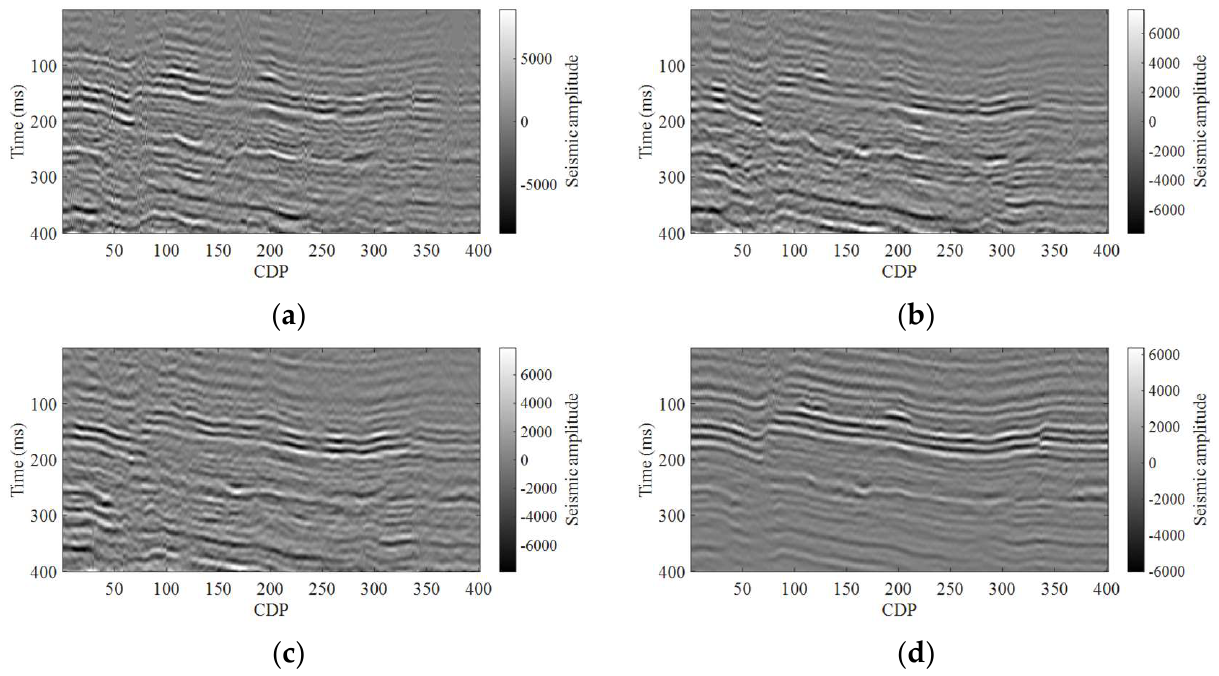
Figure 12. The observed prestack angle gathers of ( a ) 0°, ( b ) 15°, and ( c ) 30° for seismic inversion. ( d ) The poststack seismic record used for interpolation.